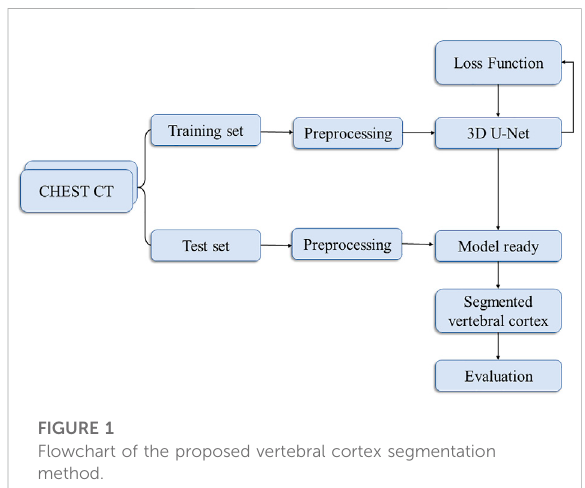
FIGURE 1 Flowchart of the proposed vertebral cortex segmentation method.